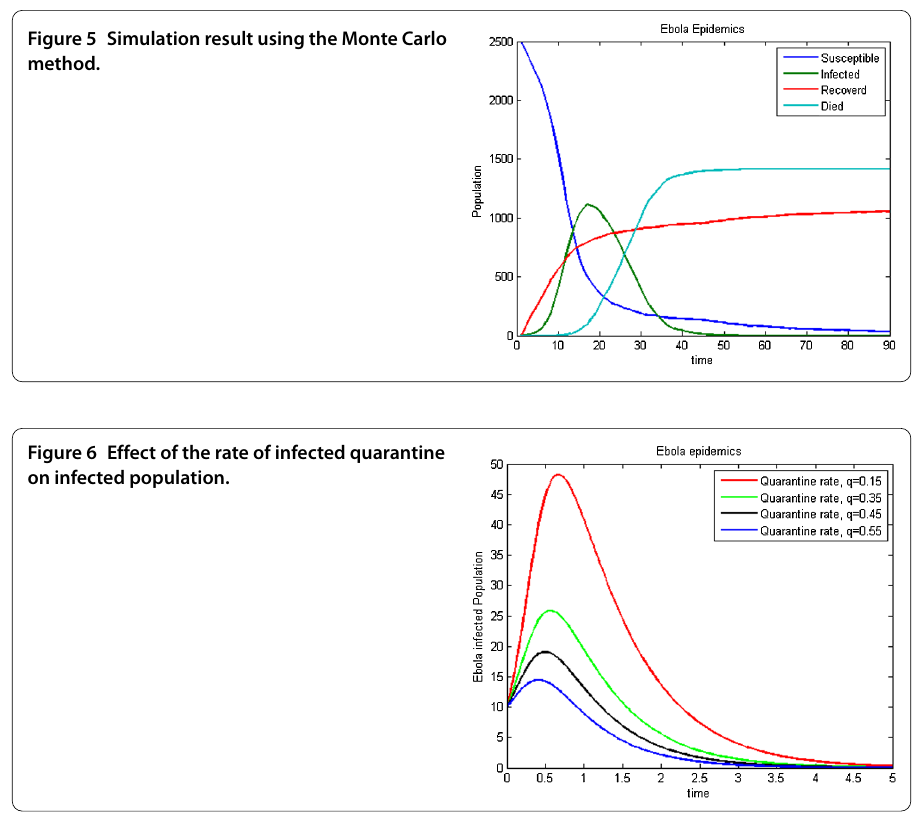
Figure 5 Simulation result using the Monte Carlo method.